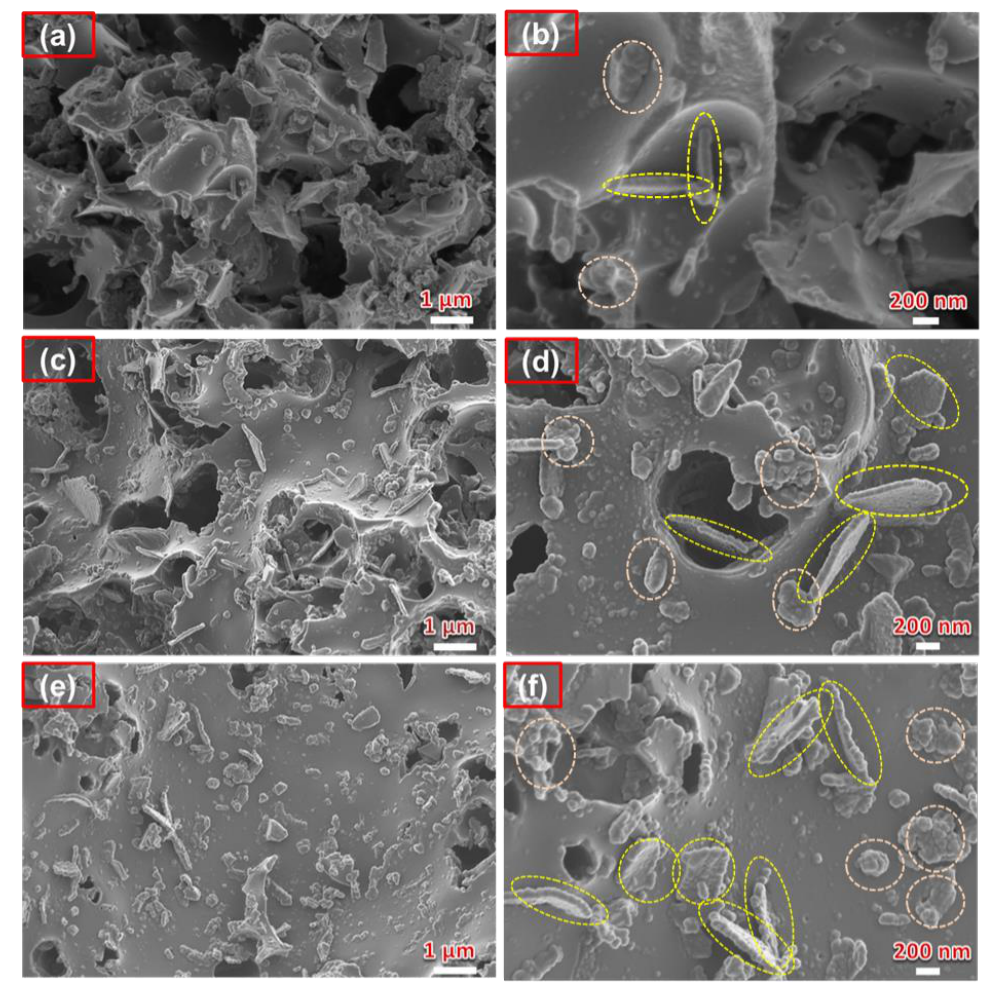
Figure 4. SEM micrographs at low and high magnification of ( a , b ) PAC/MoO 2 /Mo 2 C-0.5, ( c , d ) PAC/MoO 2 /Mo 2 C-1 and ( e , f ) PAC/MoO 2 /Mo 2 C-2 ternary composites.